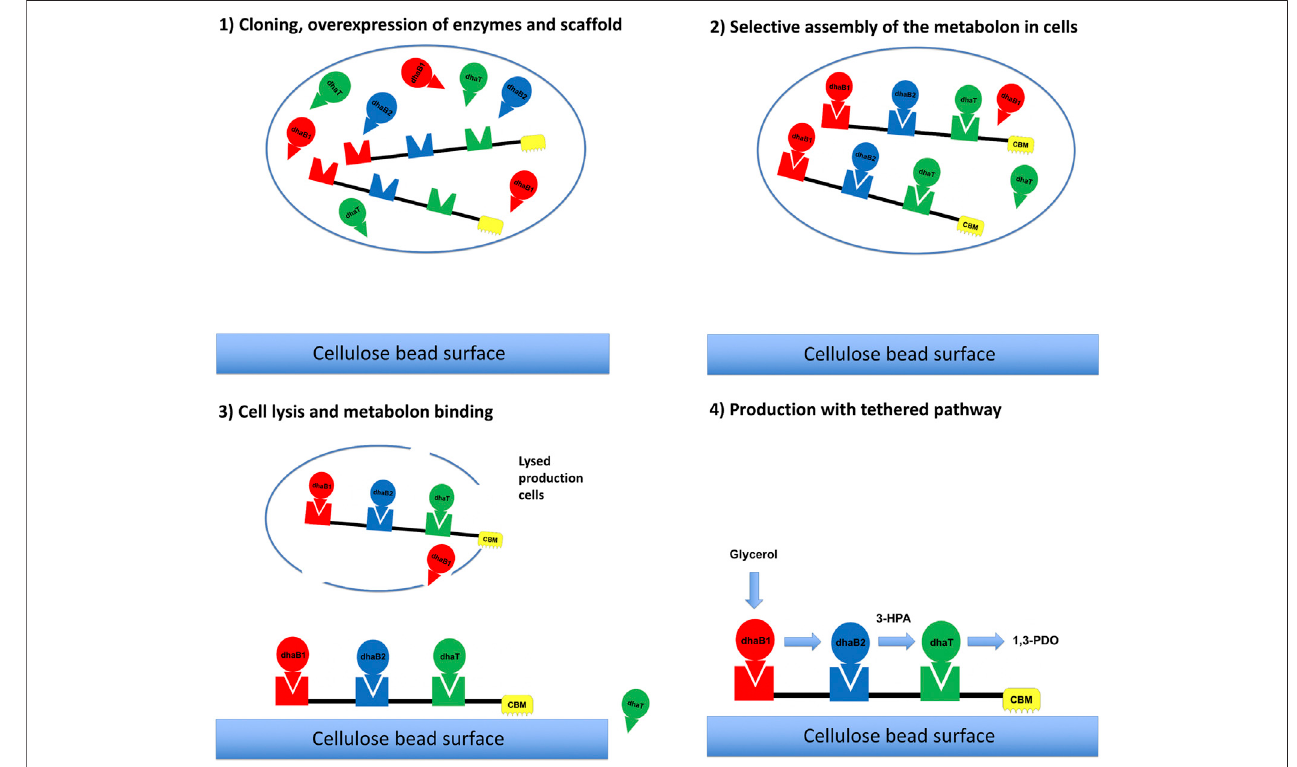
FIGURE 5 | Depiction of the process for the in vitro production of 1,3-PDO from glycerol using a self-assembling metabolon including (A) Expression of enzymes and protein scaffolds, (B) Self-assembly of the metabolon in cells, (C) Cell lysis and speci fi c metabolon binding to cellulose, and (D) 1,3-PDO production in vitro . All symbols are described in Figure 1 .